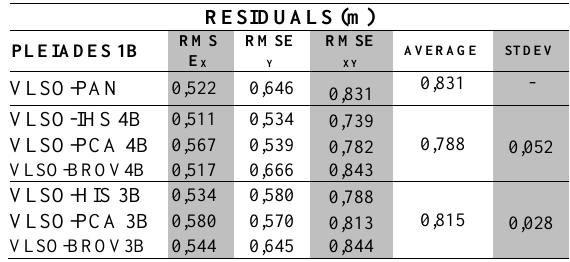
Table 1: Resulting residuals for the performed experiments on Pleiades 1B when compared with the control dataset